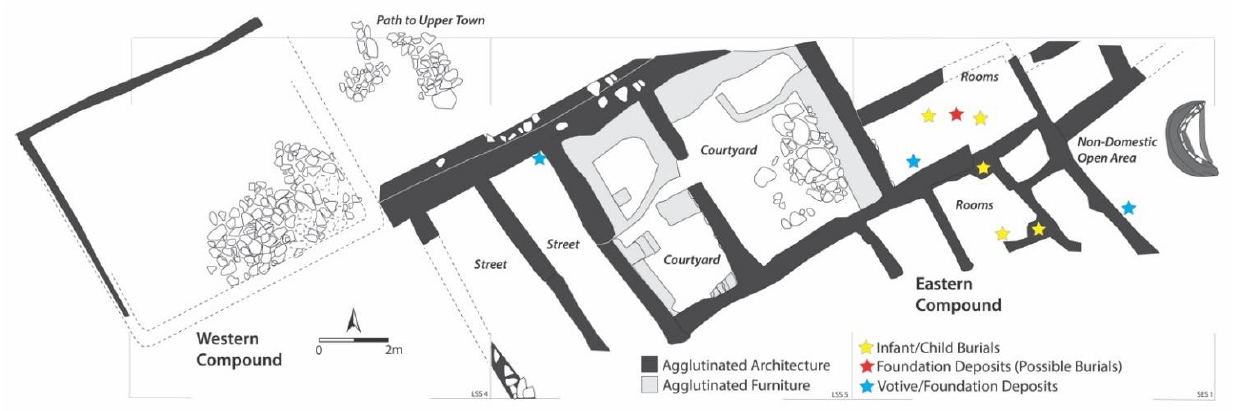
Figure 4. Plan of the Agglutinated phase showing locations of infant/child burials and votive/foundation deposits.